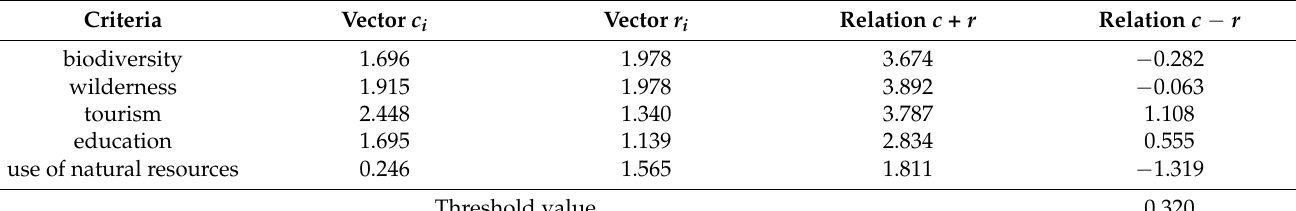
Table 5. DEMATEL relation between criteria matrix.